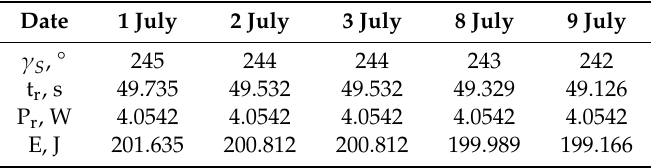
Table 4. Power consumption of schedule solar tracker’s